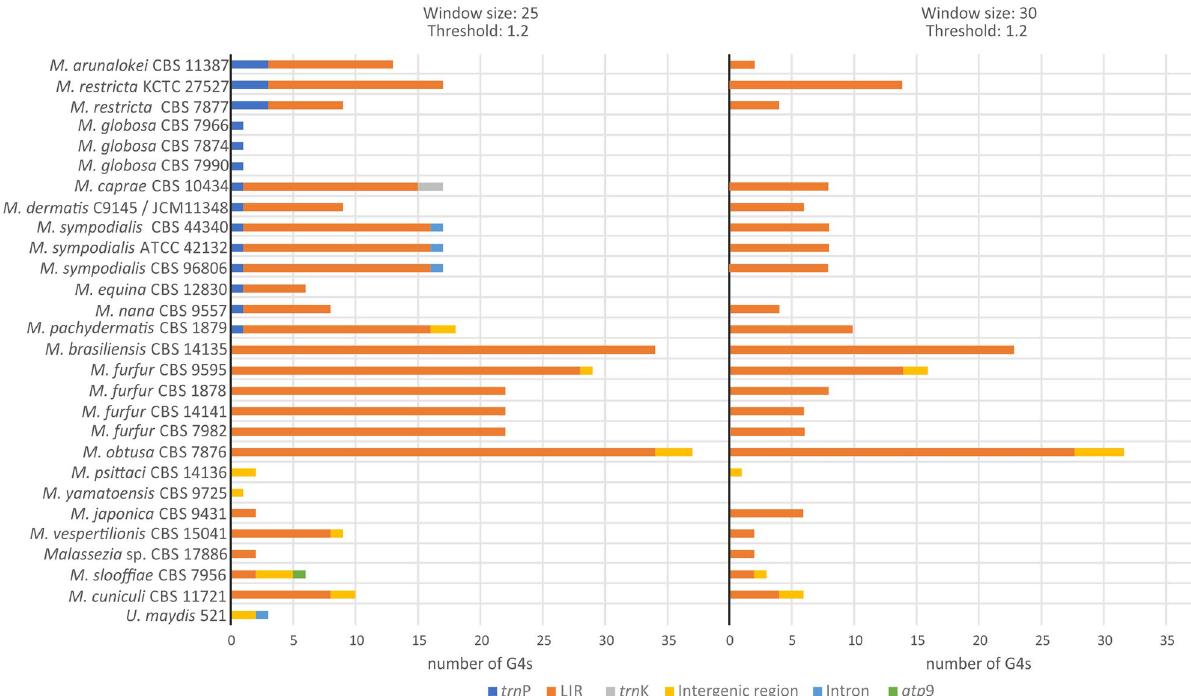
Figure 4. The G-quadruplex distribution in Malassezia mitogenomes. Bar graphs of the predicted G4s with threshold 1.2 and window size 25 (left) or window size 30 (right). The G4s located in the trn P, LIRs, trn K, intergenic regions, introns and atp 9 gene are shown with blue, orange, grey, yellow, light blue and green color, (Table 2). Among all predicted G4s with both parameters, the loop length varied from one to 18 bp, and G4 sequence conservation was only detected at the intra-species level (Suppl. Table S4). Discussion